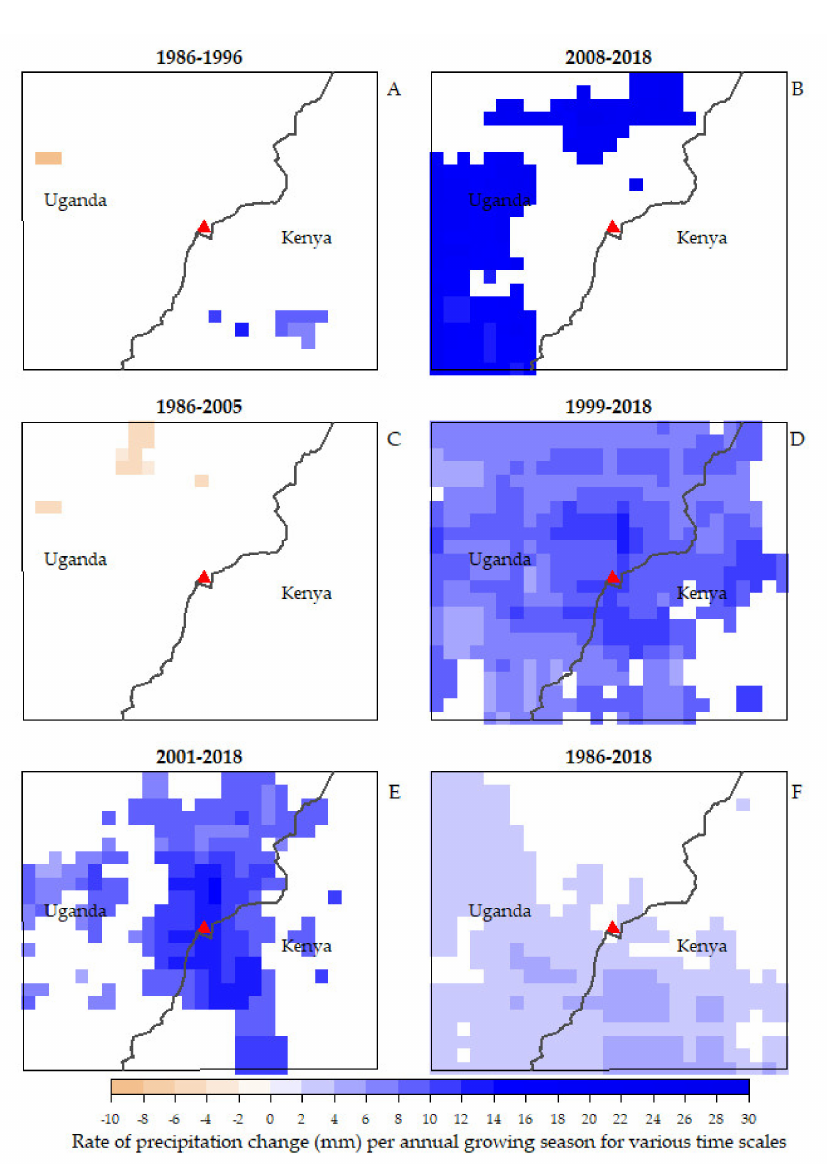
Figure 6. ( A – F ) Maps of precipitation change for each analyzed time